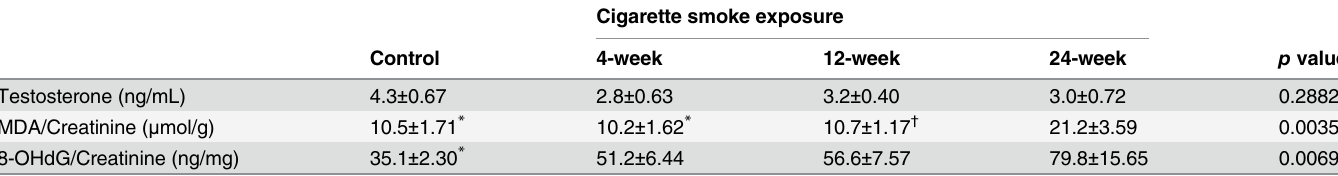
Table 2. Plasma testosterone concentration and urine oxidative stress